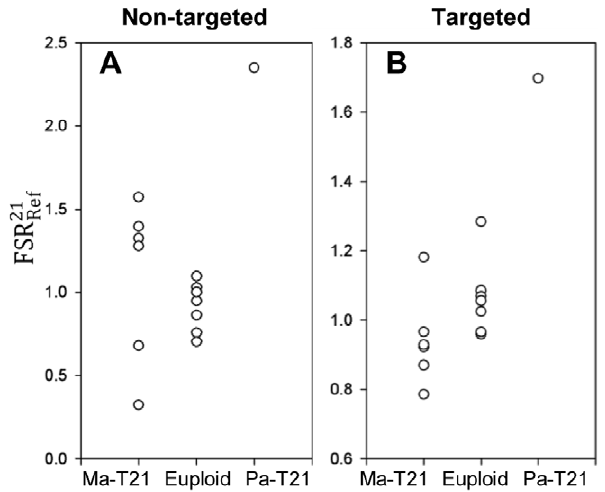
Figure 2. T21 detection by F-S ratio in non-targeted and values were calculated to targeted sequencing data. FSR 21 Ref differentiate the paternally- and maternally-derived T21 from the euploid fetuses in non-targeted (A) and targeted (B) sequencing data. (Ma-T21: maternally-derived T21. Pa-T21: paternally-derived T21.). ( FSR 21 = 2.35) could be differentiated from the euploid group Ref ( FSR 21 mean 0.91, median 0.96, range: 0.70 to 1.10). On the Ref other hand, the maternally-derived T21 cases ( FSR 21 mean 1.10, Ref median 1.30, range: 0.33 to 1.57) overlapped with the euploid